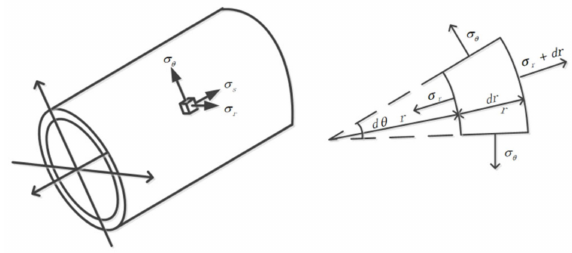
Figure 6. Stress distribution of the micro-body of a thick-walled